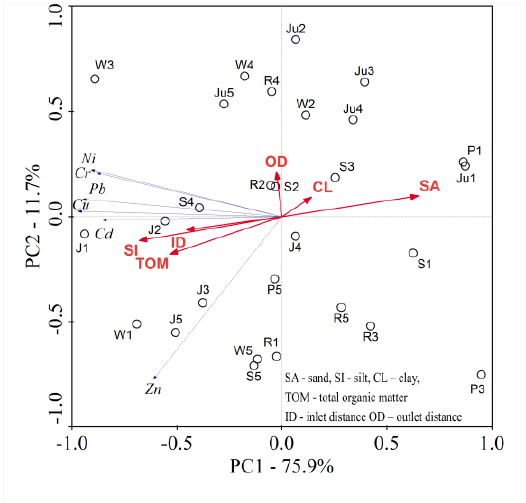
Figure 6. HMs concentration with respect to bottom sediment sample texture, total organic matter content and location.